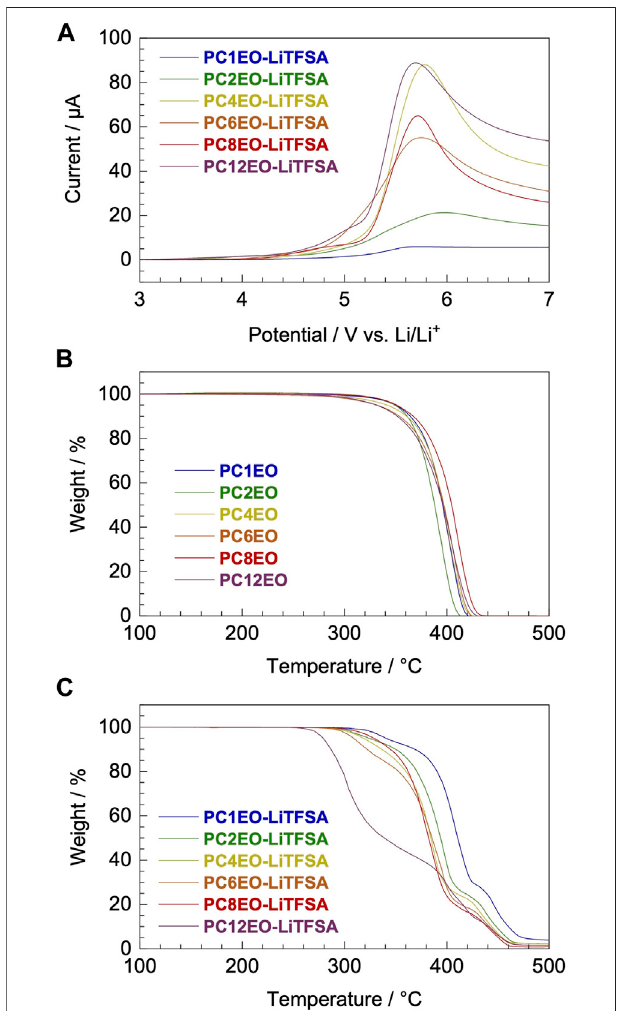
FIGURE 2 | Electrochemical and thermal stability of newly synthesized PCmEO and corresponding electrolytes. (A) Linear sweep voltammogram from rest potential (ca. 3.0 V) to 7.0 V for PCmEO-LiTFSA on stainless steel working electrode at a scan rate of 1 mV s − 1 . Thermogravimetric (TG) curves of (B) PCmEO (pure polymers) and (C) PCmEO-LiTFSA (PEs). TG curve was obtained under He atmosphere at a heating rate of 20 ° C min − 1 . Thermogravimetry of the PEs was performed after pre-heating at 150 ° C for 10 mintoremovewater.Theblue,green,yellow,orange,red,andpurplelines show m = 1, 2, 4, 6, 8, and 12,